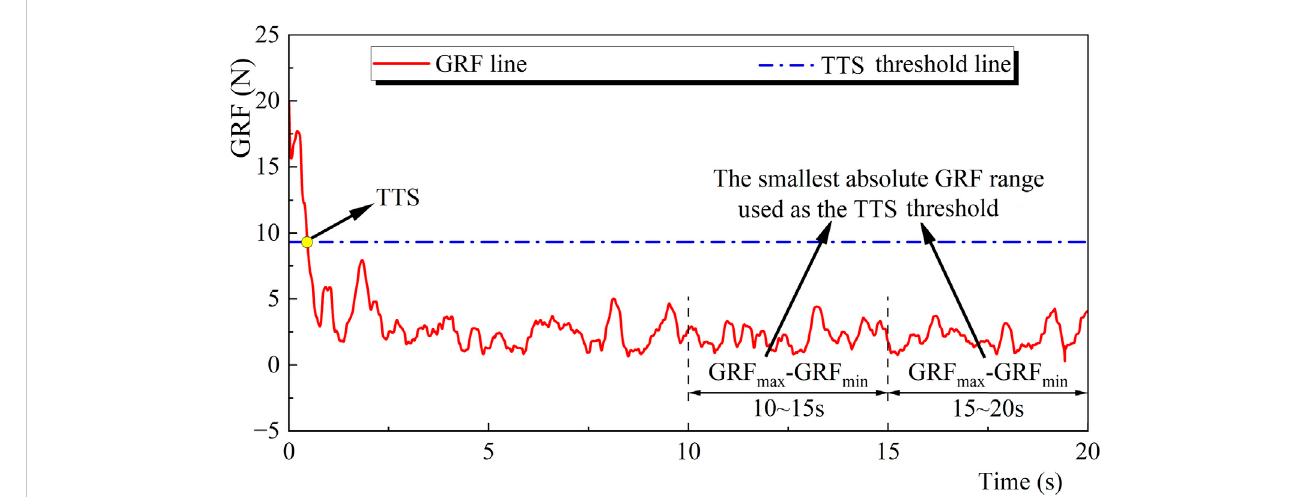
FIGURE 2 Illustration of the TTS calculation. Note: GRF, Ground reaction force; TTS, Time to stabilization.